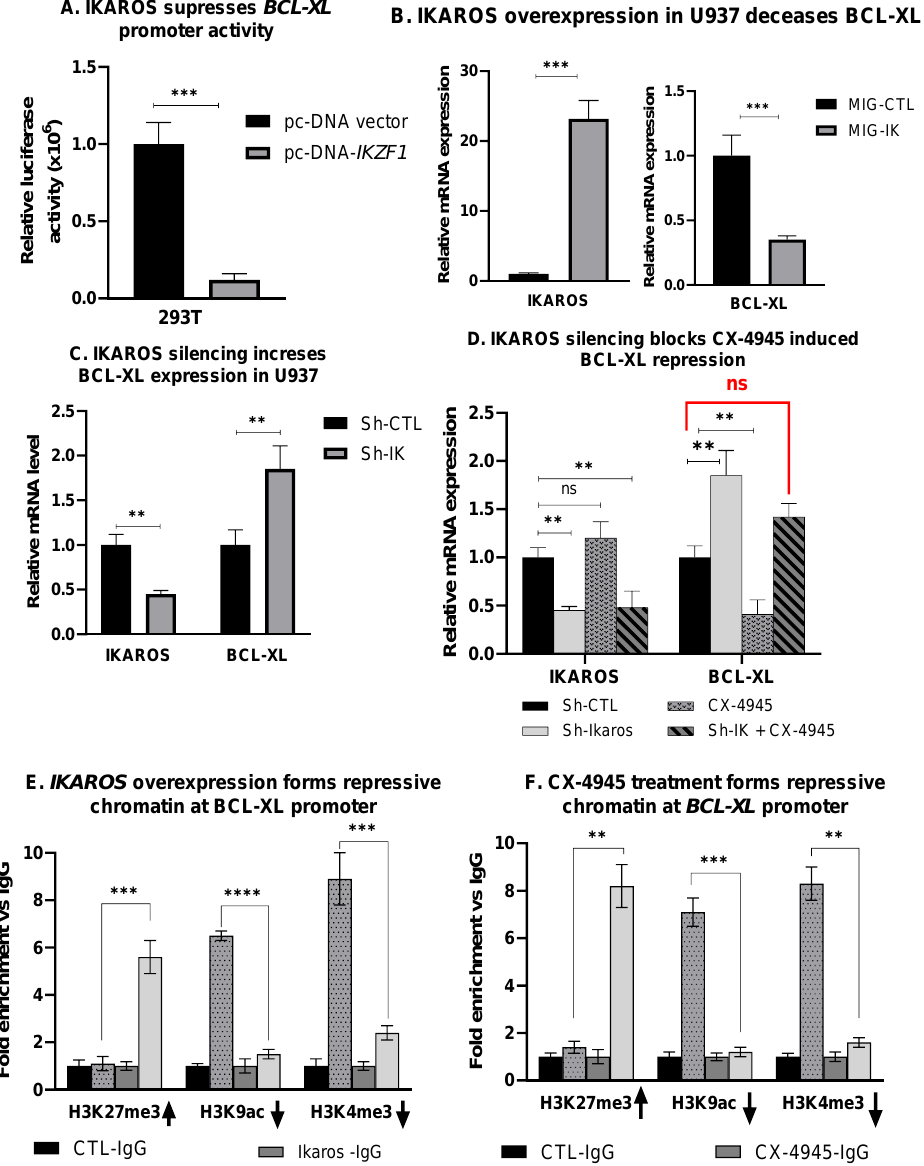
Figure 5. IKAROS represses BCL-XL gene transcription in AML. The luciferase reporter assay was performed on HEK-293T cells transfected with IKZF1 plasmid (pcDNA-IK) or the control vector. Result in ( A ) shows repression of the BCL-XL luciferase promoter construct by the IKAROS-expressing vector pcDNA3.1-IK in comparison to the pcDNA3.1 empty vector control in HEK-293T cells. The luciferase activity was normalized to pcDNA3.1 and pROM empty vector controls. ( B ) U937 cells were transduced to express IKZF1 (MIG-IK) or with an empty vector (MIG-CTL). The relative mRNA expression of IKAROS and (left panel) BCL-XL (right panel) were assessed using qRT-PCR. ( C ) U937 cells were treated with IKZF1 shRNA (shIK) or scramble shRNA control (shCTL). The relative expression of IKZF1 (left panel) and BCL-XL (right panel) assessed by qRT-PCR. ( D ) U937 cells were treated with IKZF1 shRNA (shIK) or scramble shRNA control (shCTL). IKAROS knockdown U937 cells were then treated with 10 µ M of CX-4945 for 48 h. Changes in BCL-XL gene expression were measured using qPCR. Figure 5E,F shows the qChIP assay showing an enrichment of histone markers at the BCL-XL promoter. The qChIP assay was performed using ( E ) IKAROS overexpressing (MIG-IKZF1) U937 cells and ( F ) CX-4945 treated U937 cells (10 µ M for 48 h) to determine the fold enrichment of histone markers, H3K27me3, H3K9ac, and H3K4me3 at the BCL-XL promoter and compared to the control cells. P-value summaries are as follows: p > 0.05 (ns- not significant); p < 0.01 (**); p < 0.001 (***); p < 0.0001 (****). Results are the mean +/– SD of three independent